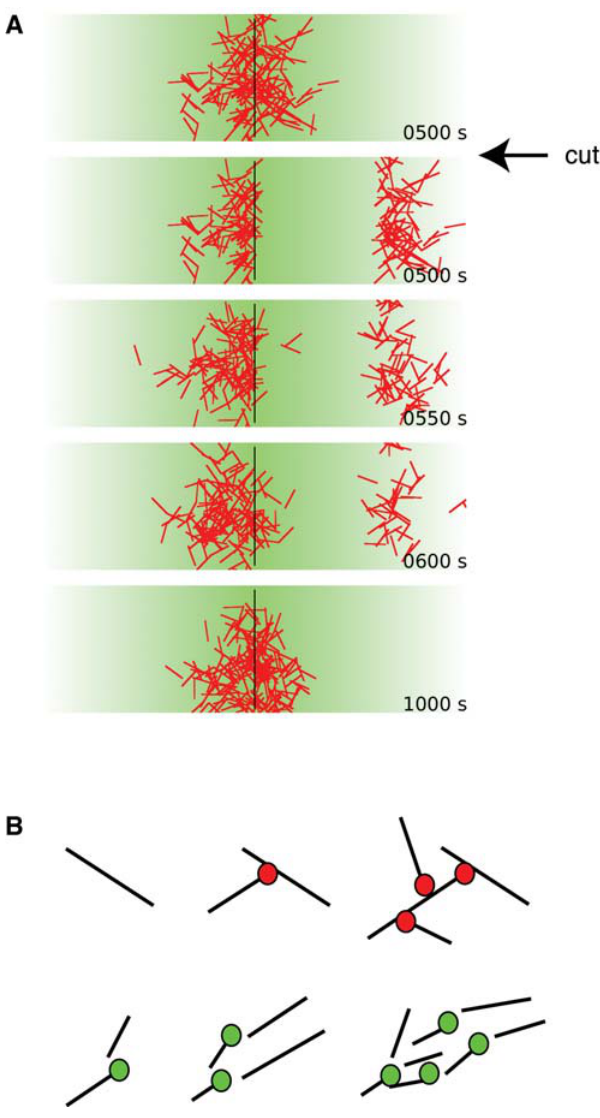
Figure 4. Autocatalytic MT production, dynamic instability, and a RanGTP gradient render MT super-structures robust toward external perturbations. A. The MT super-structure can regenerate within a RanGTP gradient. A fully assembled MT super-structure (top) is divided in two, and one half is moved 20 m m to the right. As MTs disassemble due to dynamic instability, new MTs are produced preferentially in the centre of the gradient. Thereby the severed half disintegrates over time and the integrity of the MT super-structure is re- established. B. Time series of two different mechanisms to achieve autocatalytic MT production. The top series shows a nucleator (red) binding to MTs where it becomes activated and nucleates new MTs. The bottom series shows a MT severing protein (green) binding to MTs and cutting them into fragments. These fragments can grow into new MTs.